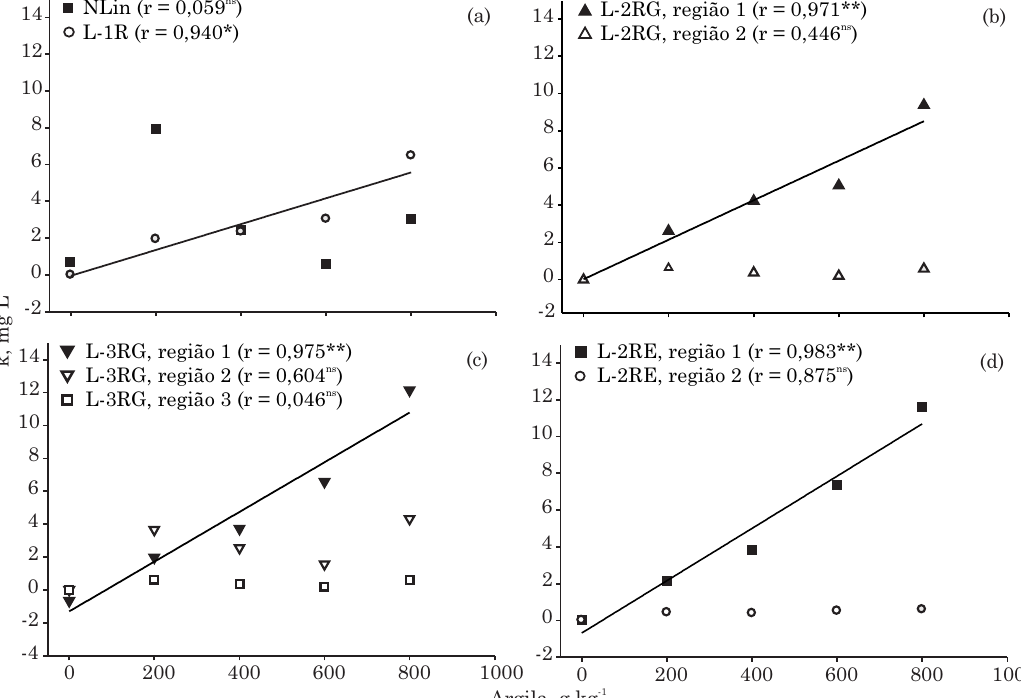
Figura 2. Relação entre o teor de argila do solo e a constante relacionada com a energia de ligação do modelo de Langmuir (k), em solos com diferentes teores de argila. Modos de ajuste do modelo: NLin = não linear com região única e L-1R = linearização com região única (a); L-2RG = linearização com duas regiões, ajuste gráfico (b); L-3RG = linearização com três regiões, ajuste gráfico (c); e L-2RE = linerização com duas regiões, ajuste estatístico (d). *: p<0,05; **: p<0,01; e ns: